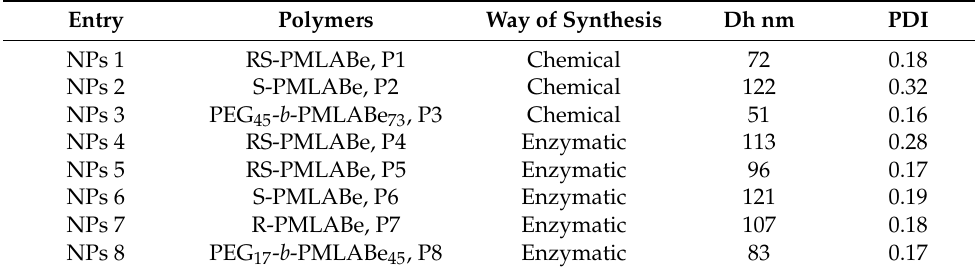
Table 5. Characteristics of the nanoparticles prepared for the in vitro cytotoxicity assays. Entry Polymers Way of